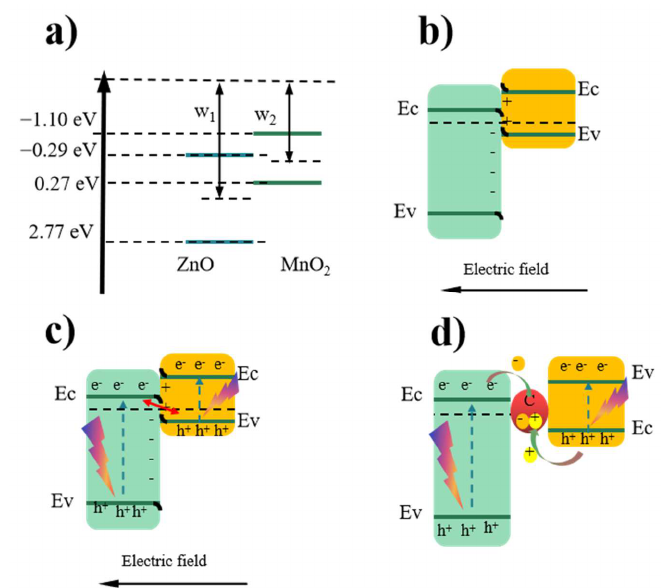
Figure 11. ZnO, MnO 2 band structure ( a ); ZnO and MnO 2 charge distribution on contact ( b ); ZnO and MnO 2 carrier transport mechanism ( c ); ZnO‐C/MnO 2 heterojunction Z‐scheme carrier transport mechanism ( d ).